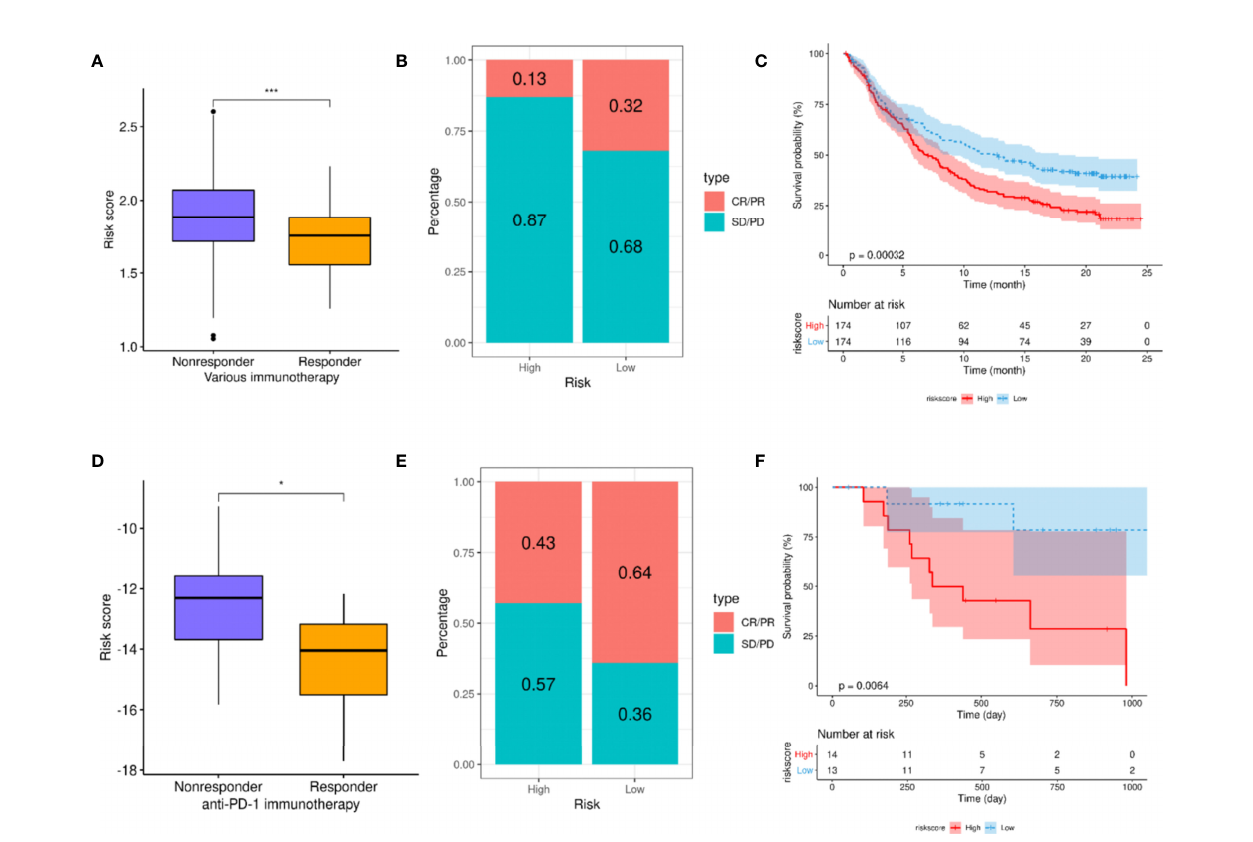
FIGURE 9 | A high-risk score predicts poor response to immune checkpoint inhibitors (ICIs). (A – C) Exploration of the utility of risk scores as prognostic markers for ICIs using the Imvigor210CoreBiologies dataset. (A) Comparison of risk scores between different immune response states. (B) Comparison of immune response ratio between high- and low-risk groups. (C) Overall survival (OS) analysis of high- and low-risk groups. (D, E) Veri fi cation of relationship between risk score and immune response using the GSE78220 dataset. (D) Comparison of risk scores between different immune response groups. (E) Comparison of immune response rates between high- and low-risk groups. (F) Analysis of the OS of patients in high- and low-risk groups. For t-test: * p < 0.05; *** p <